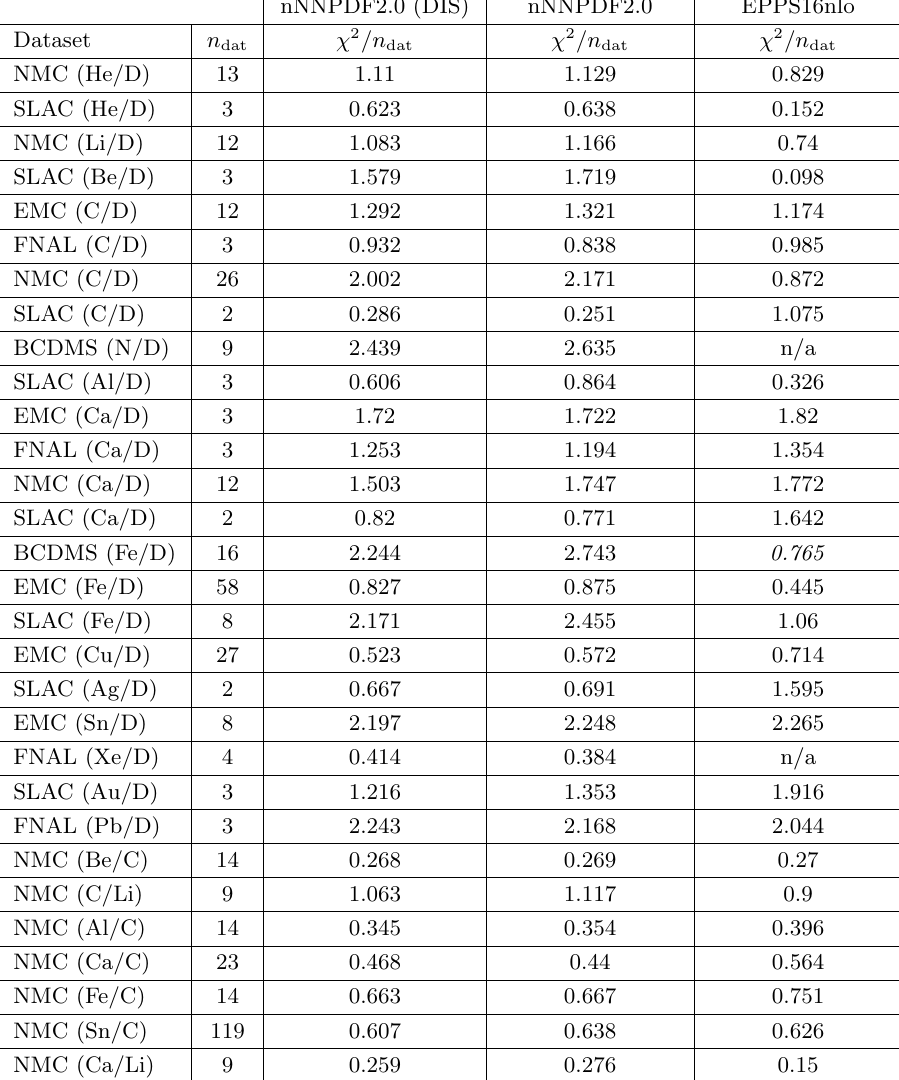
Table 4 . The values of the (cid:31) 2 per data point for the DIS neutral current structure function datasets included in nNNPDF2.0. We compare the nNNPDF2.0 global and DIS-only results with those obtained using EPPS16 as input for the theory